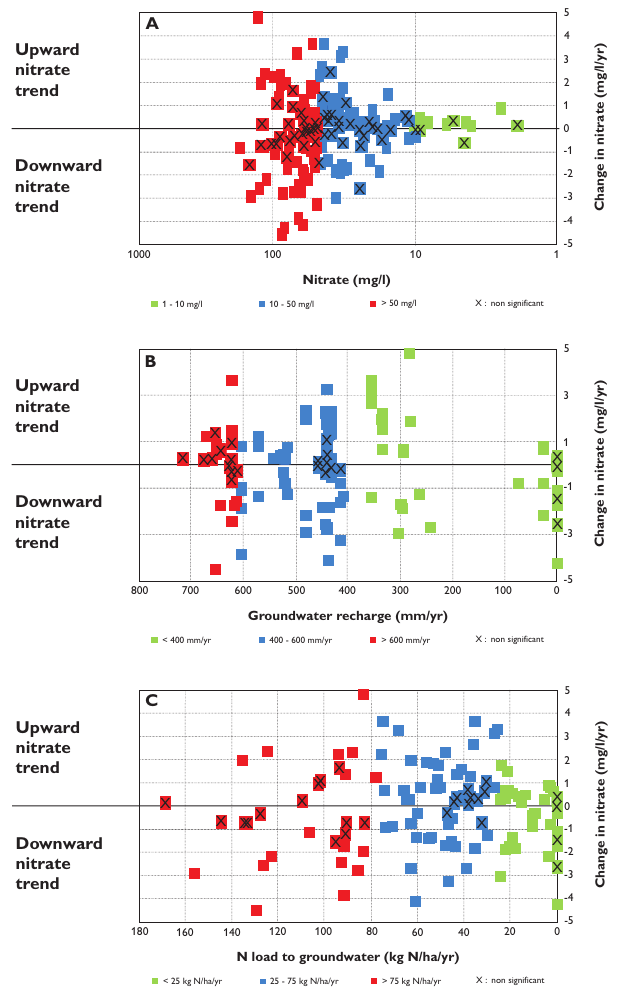
Fig. 5. Upward and downward nitrate trends in 152 oxic CFC- dated groundwater monitoring points sampled from 1988 to 2009. (A) The mean nitrate concentration (mgl − 1 ) in each groundwater monitoring point. (B) The annual groundwater recharge (mmyr − 1 ) in a circle of 1km around each groundwater monitoring point. (C) the N load (kgNha − 1 yr − 1 ) to groundwater based on data shown in (A) and (B)